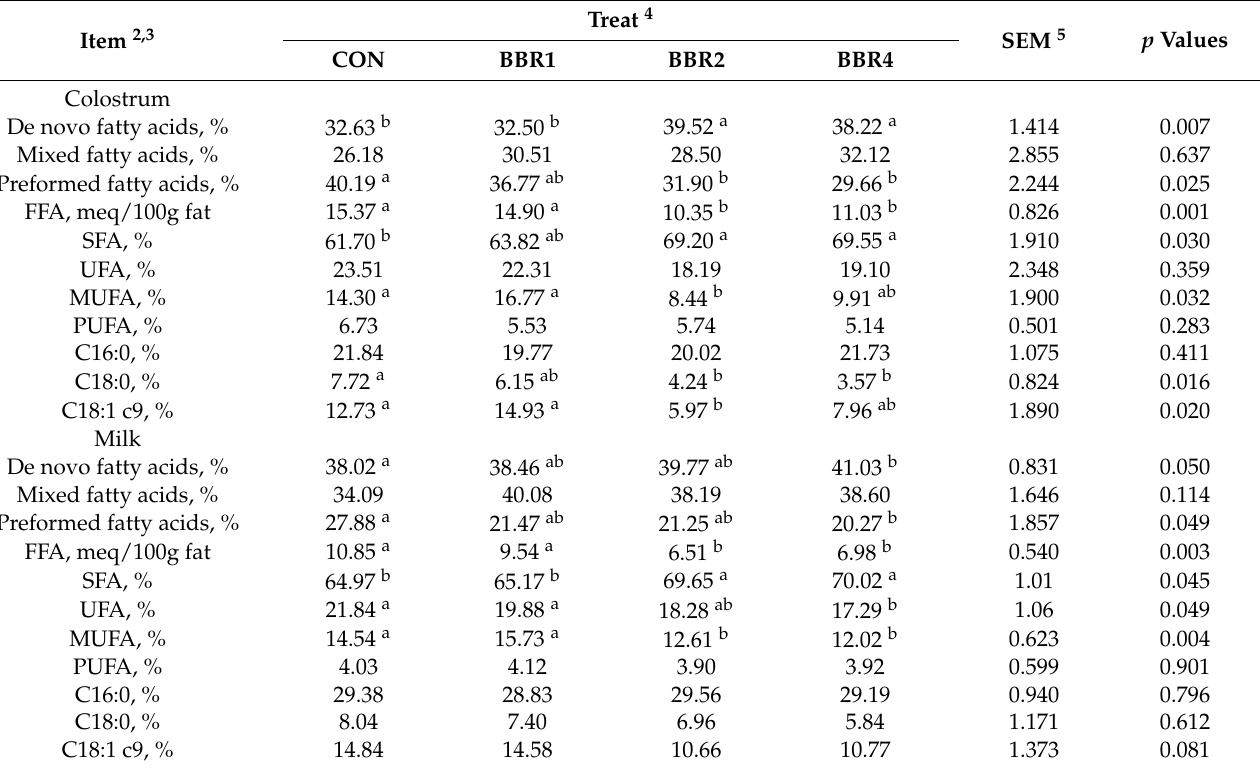
Table 6. Effect of Berberine (BBR) supplementation on colostrum and milk fatty acid profile of dairy Saanen goats 1